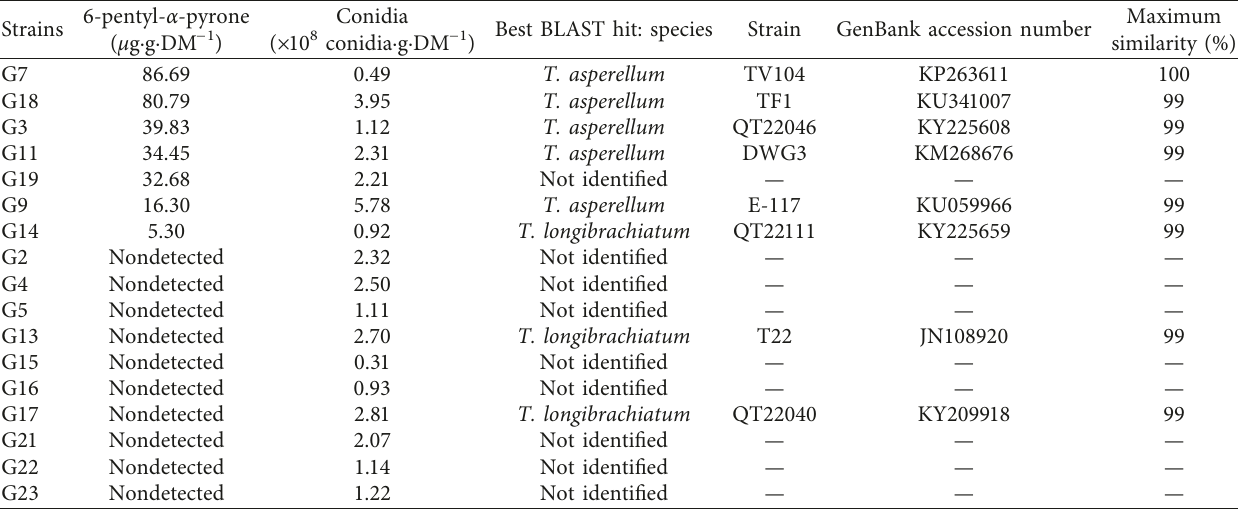
Table 1: Comparison of 17 strains of Trichoderma for their ability to produce 6-PP and conidia after 8days of cultivation and molecular identification by ITS1 rDNA regions sequencing.